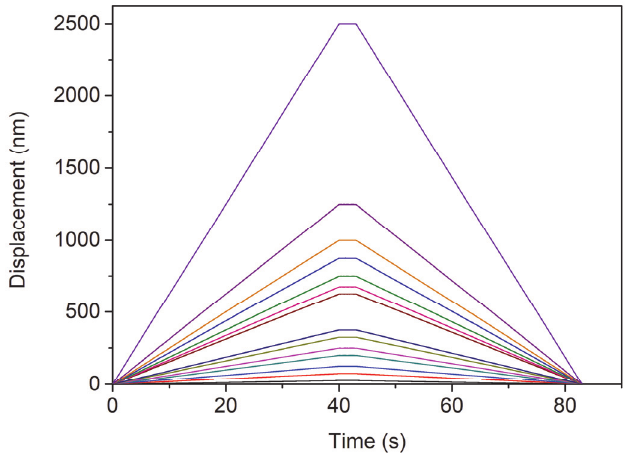
Figure 6: Load curves of MWCNT/PP 2 wt% specimen nanoindentation as a function of time